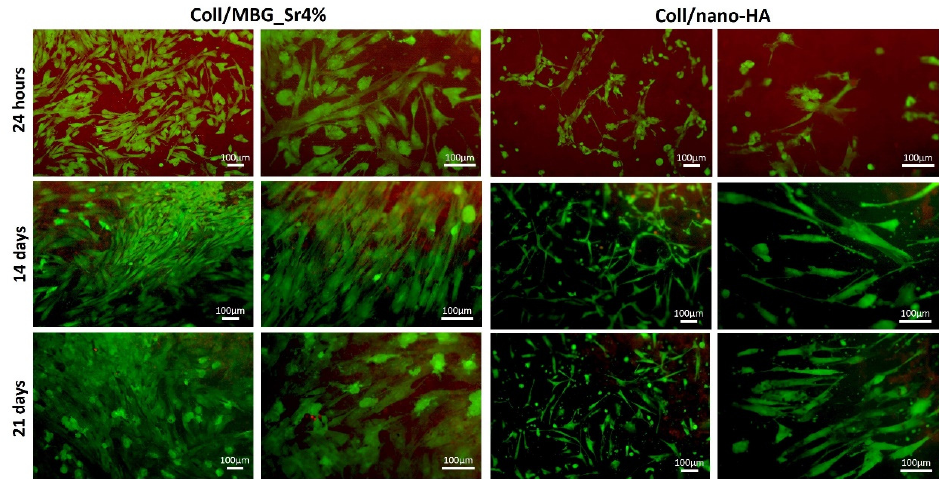
Figure 6. Representative images of OBs stained with the Live Dead assay, showing good cell viability at the different time points.